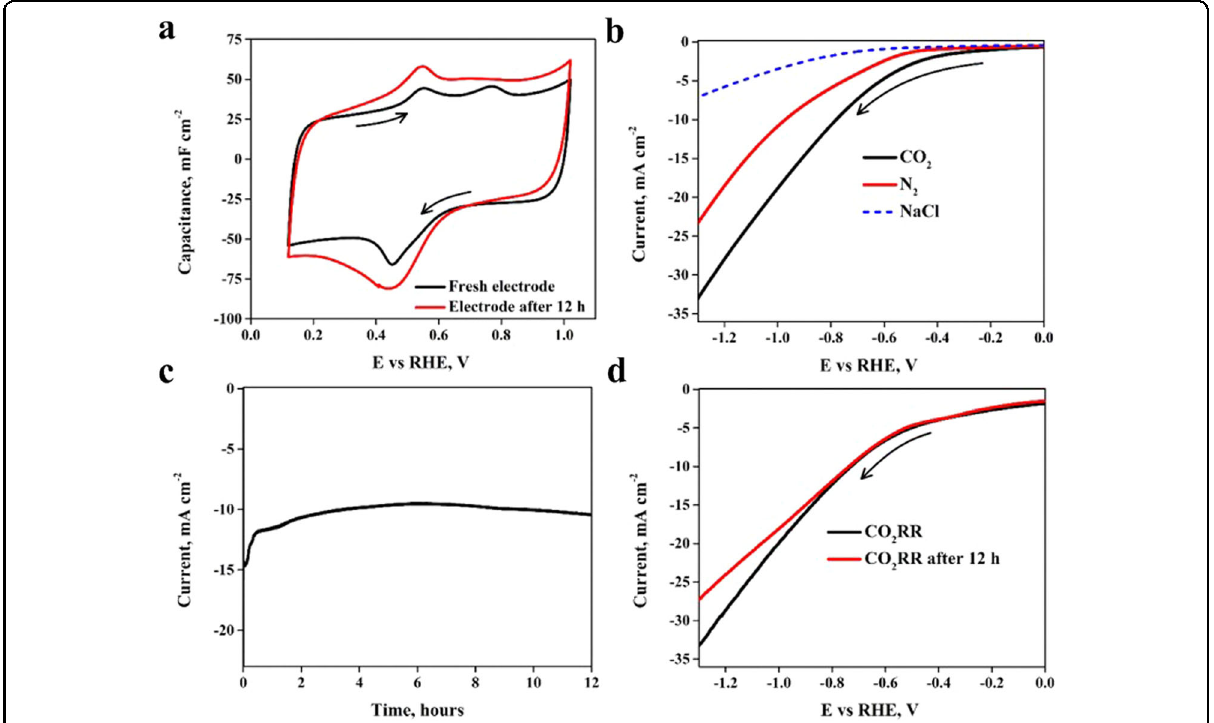
Fig. 4 Electrochemical measurements. a Cyclic voltammetry with a fresh composite electrode and with the same electrode after stability testing at a potential of − 0.9 V vs. RHE for 12 h. b LSV using the HKUST-1@AC composite as the cathode in N 2 - and CO 2 -saturated 0.5 M KHCO 3 electrolyte. LSV data obtained with 1 M NaCl is shown in dashed lines for comparison. c Chronoamperometric measurement at a constant potential of − 0.9 V vs. RHE for 12 h. d LSV of the same composite catalyst after the fi rst cycle and after 12 h of chronoamperometry at a constant